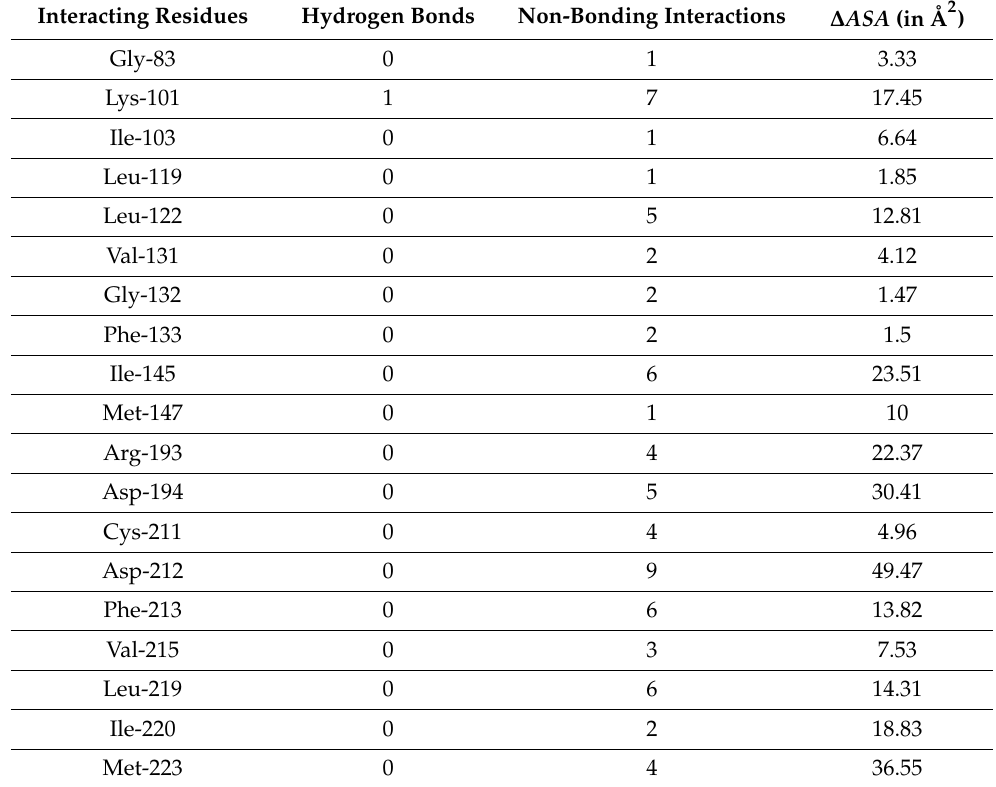
Table A6. The MEK2 residues interacting with selected flavonoid M2F6 are listed with the number of non-bonding interactions and ∆ ASA .